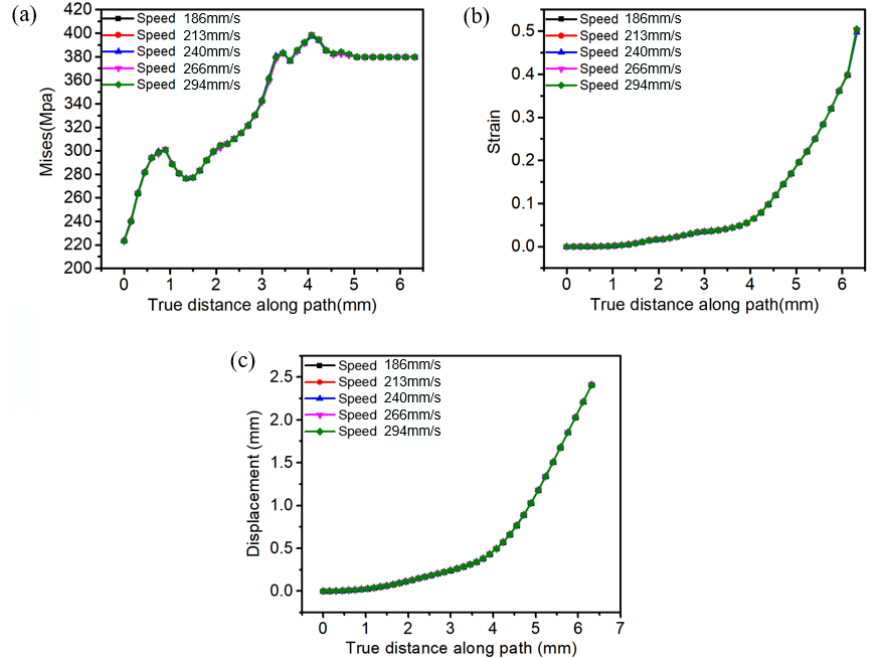
Figure 9. Values of equivalent stress ( a ) equivalent plastic strain and ( b ) radial displacement ( c ) at